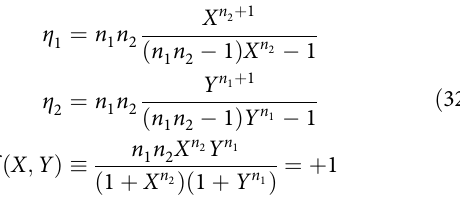
characteristic equations